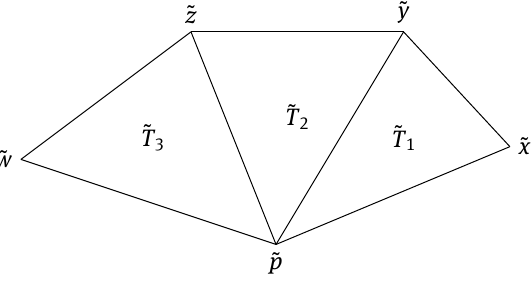
Figure 6.3: The metric space ˜ Y in the proof of Lemma 6.5.